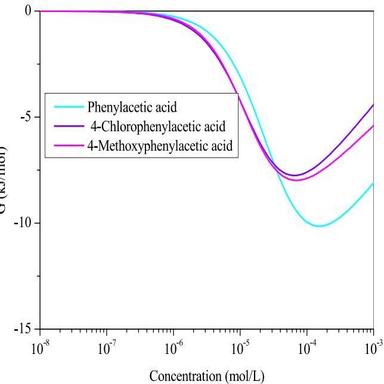
Evolution of the Gibbs free enthalpy according to phenylacetic acid, 4 chlorophenylacetic acid, and 4-methoxyphenylacetic acid concentration.